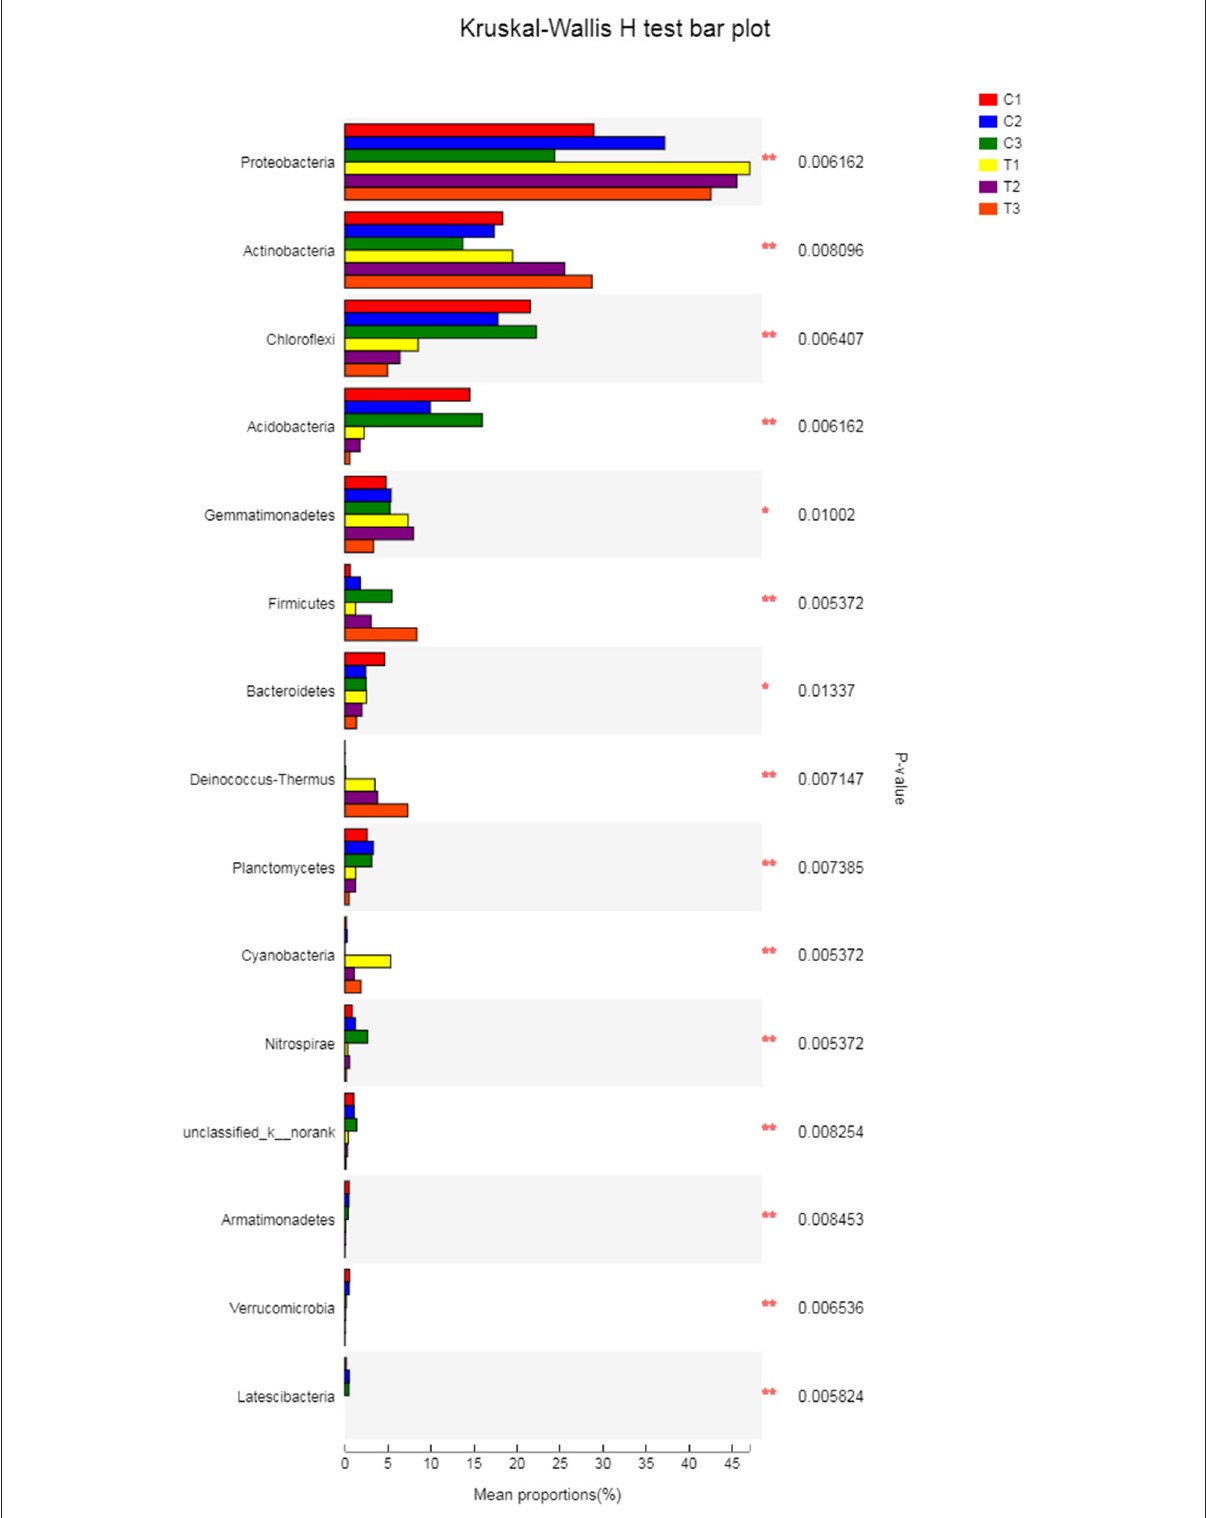
FIGURE9 The Kruskal-Wallis H -test was chosen to detect the richness of microbial communities exhibited by different samples at the phylum level. All data in the experiment represent three independent experiments.